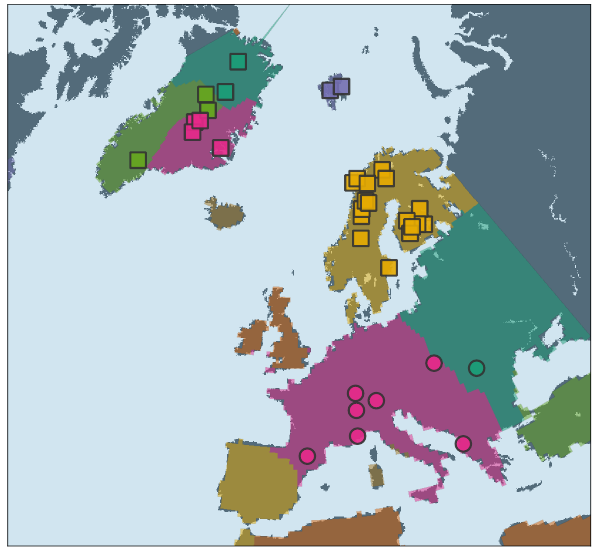
Figure 3. Division of the study area as obtained by cluster analysis of the ERA-20C summer mean temperatures, together with the pa- leoclimate archives used in this study ( α C ≈ 0 . 01). Non-adjacent regions of the same colour represent different clusters, as are indi- cated by different symbols (squares vs. circles) showing the spatial locations of the considered